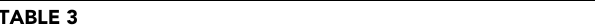
Unstandardised (b) and Standardised ( β ) Regression Coefficient, and Squared Semi-Partial Correlations (sr 2 ) for Each Predictor Variable on Each Step of a Hierarchical Multiple Regression Predicting Precursor Steps to Transformative Learning Variable b [95%% CI] β sr 2 Transformative learning